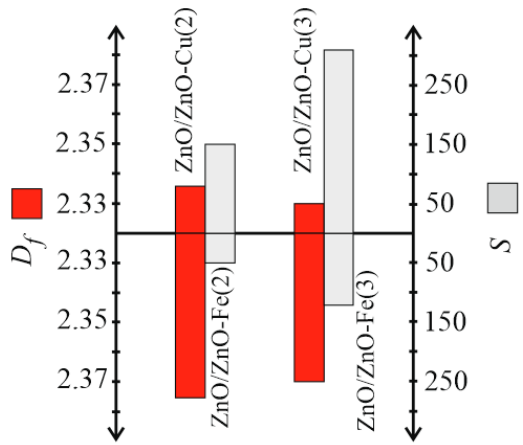
Figure 7. Correlation between the surface fractal dimension of the samples calculated by the perimeter-area method and the gas sensitivity value at ethanol vapor concentration of 1000 ppm.